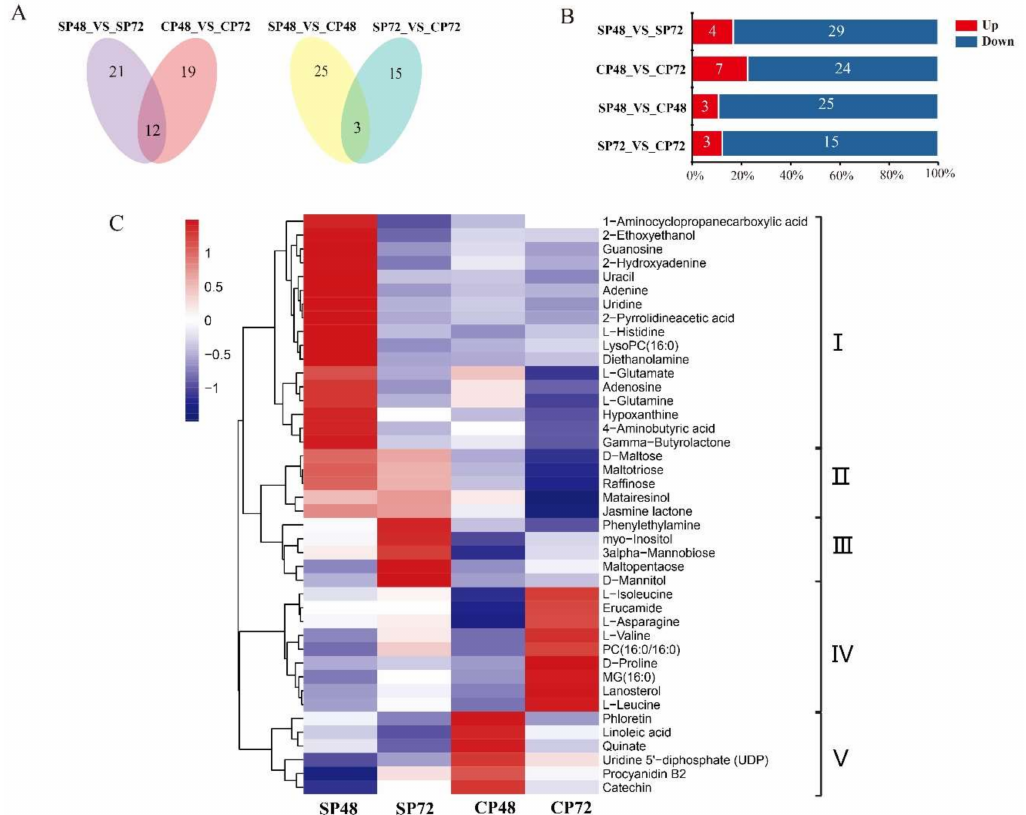
Figure 7. Di ff erentially expressed metabolites (DEMs) analysis of C. oleifera after self- and cross-pollination. ( A ) Venn diagrams of DEMs in self- and cross-pollinated pistils at 48 and 72 h. ( B ) Numbers of DEMs in self- and cross-pollinated pistils. ( C ) Hierarchical clustering analysis of DEMs after self- and cross-pollination of C. oleifera . SP48 / 72, self-pollinated pistils at 48 h / 72 h and CP48 / 72, cross-pollinated pistils at 48 h / 72